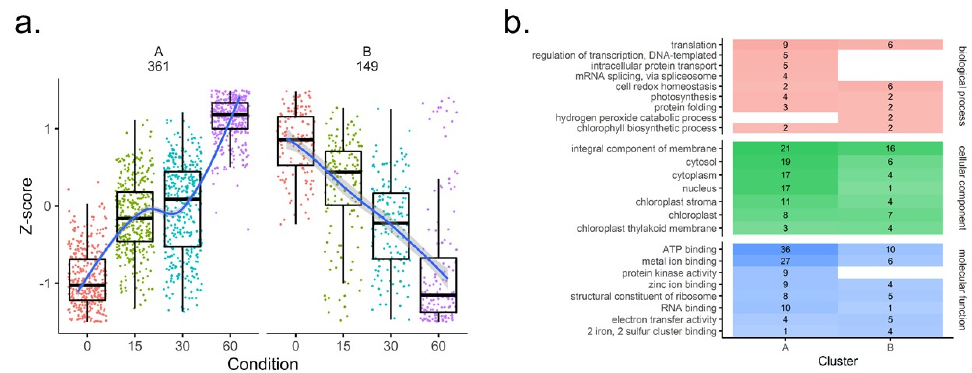
Figure 5. Differential analysis of the reversibly oxidized cysteine thiol proteome. ( a .) Hierarchical clustering of the 510 identifiers significantly changing ( p < 0.05, FC > ± 2) into two clusters. ( b .) Gene ontology (GO) summary of significantly changing identifiers in clusters A and B from hierarchical clustering analysis. The number and shading correspond to the number of unique proteins in each category for each cluster.